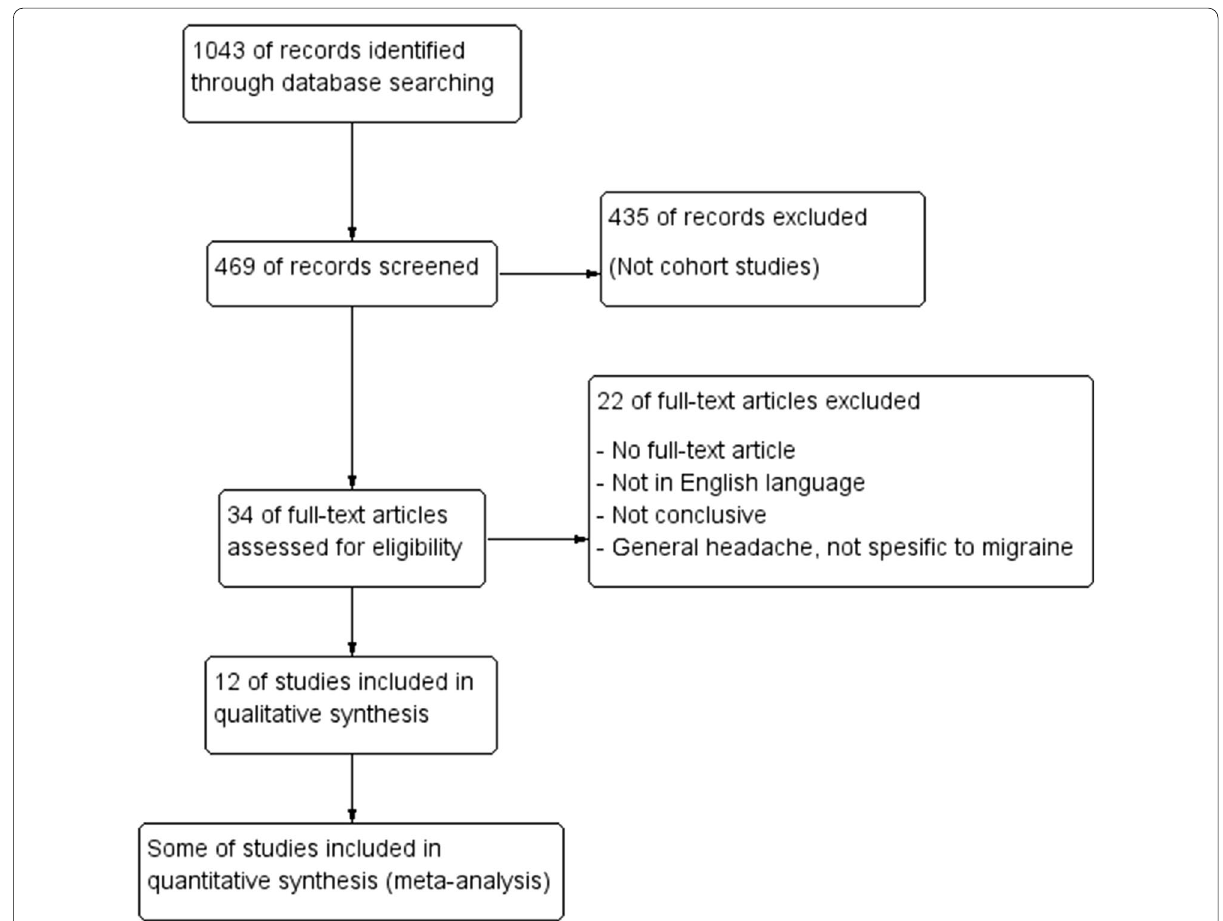
Fig. 1 Flow diagram of the search system